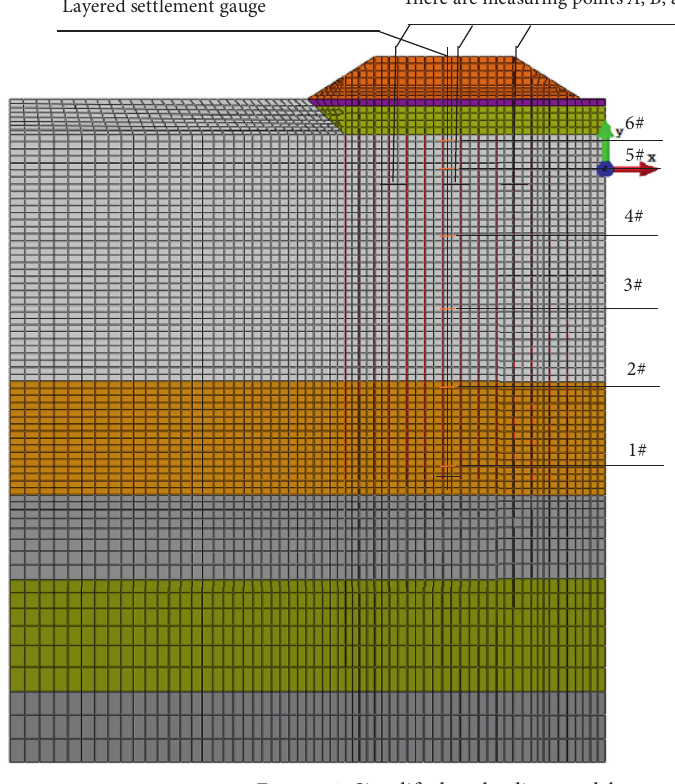
Figure 4: Simplified preloading model.